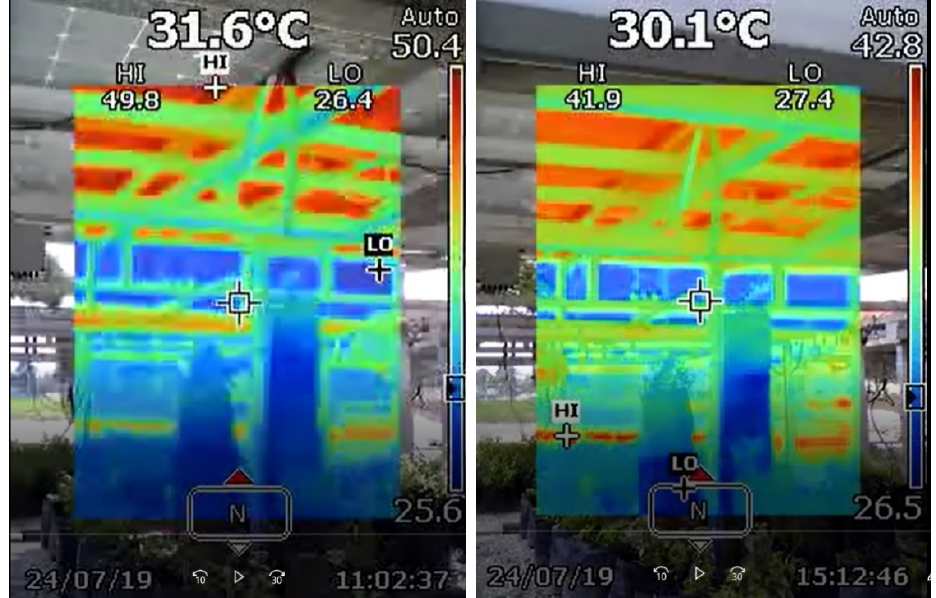
Figure 6. Thermal images of the agrivoltaic conditions for hourly sampling at the University Putra Malaysia (UPM) site.